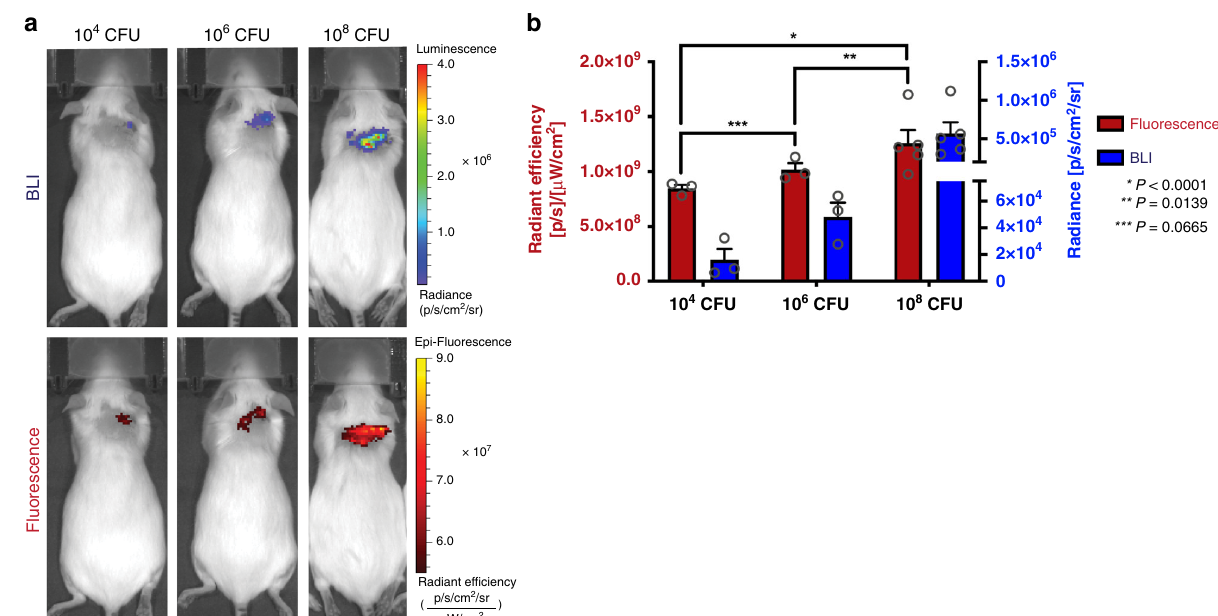
Fig. 7 In vivo evaluation of Cy7-1-maltotriose in a S. aureus wound infection murine model. a FLI and BLI of mice with a wound infected with different amounts of bioluminescent S. aureus 22 h post-injection of Cy7-1-maltotriose. FLI images (bottom) show accumulation of the probe in the S. aureus in the same area as indicated by BLI (top). b Total in vivo FLI and BLI signals in wound infected with 10 4 , 10 6 , and 10 8 CFUs of bioluminescent S. aureus ( n = 3, 3, and 5, respectively) and 22 h after tail vein injection of Cy7-1-maltotriose. Fluorescence quanti fi cation was plotted to the left y -axes (red) while BLI signal plotted to the right y -axes (blue) and showed increase in FLI signal with increase in BLI signal ( r = 0.928; r 2 = 0.8612). Bar graphs show mean and S.E.M. Statistical analysis was performed using two-way ANOVA. The source data underlying Fig. 7b are provided in a Source Data fi